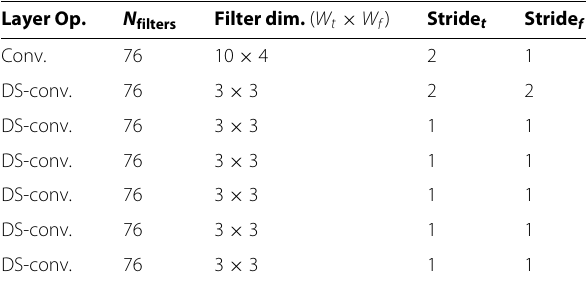
investigated in experiments Layer